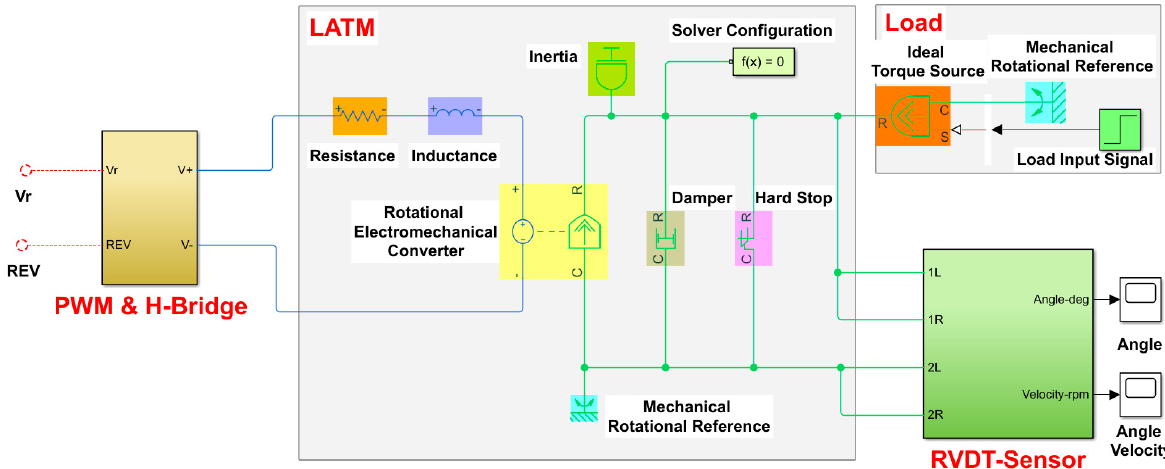
Figure 7. Integrated physical simulation model of limited-angle torque motor.